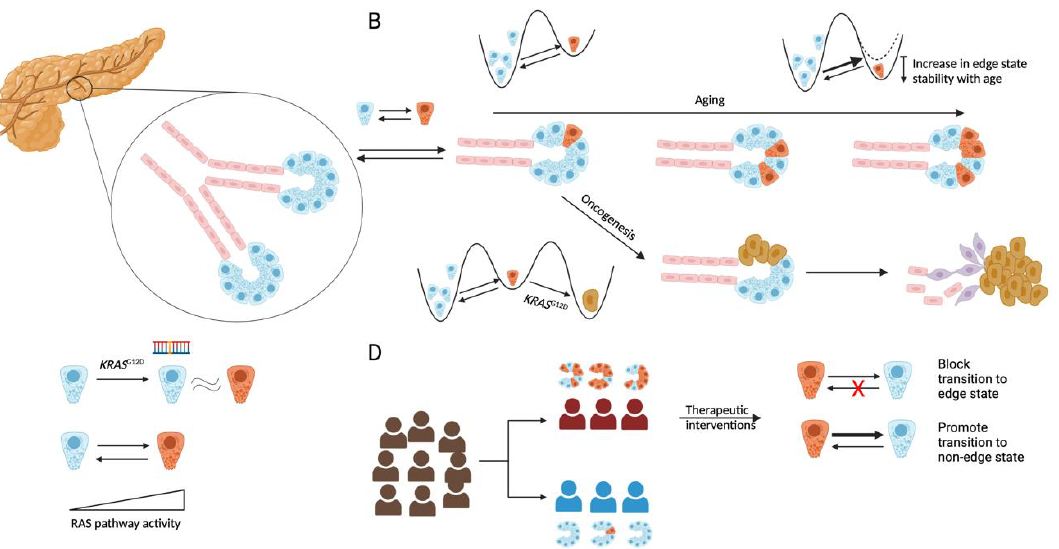
Figure 1. ( A ) Schematic of the human pancreas, with the exocrine compartment consisting of acinar cells (blue) and ductal cells (red). ( B ) Acinar cells can switch to an edge state (brown) characterized by low expression of acinar identity genes. The fraction of edge cells increases with age, which may be due to an increased transition rate to the edge state or an increase in the stability of the edge state, or a combination thereof. Cells in the edge state are predisposed to malignant transformation with the acquisition of a KRAS G12D mutation, leading to malignancy, with malignant cells existing in different phenotypic states (purple or brown) ( C ) Edge cells have high Ras activity, and the edge-like state phenocopies (at a transcriptomic level) the Kras G12D mutation in mice. ( D ) Acinar cells likely exist in an edge state in patients that are at a high risk for PDAC. Therapeutic interventions to block transitions to an edge state, or promote transitions away from the edge state, may lower PDAC risk.